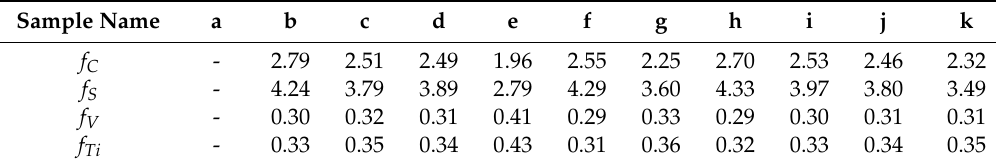
Table 8. Activity coe ffi cient of C, S, V, and